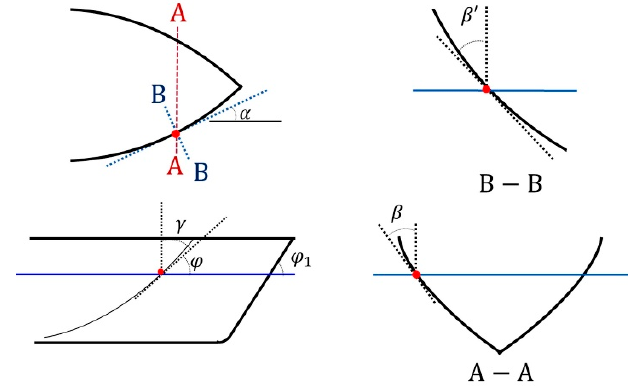
Figure 6. Definitions of hull angles at a collision